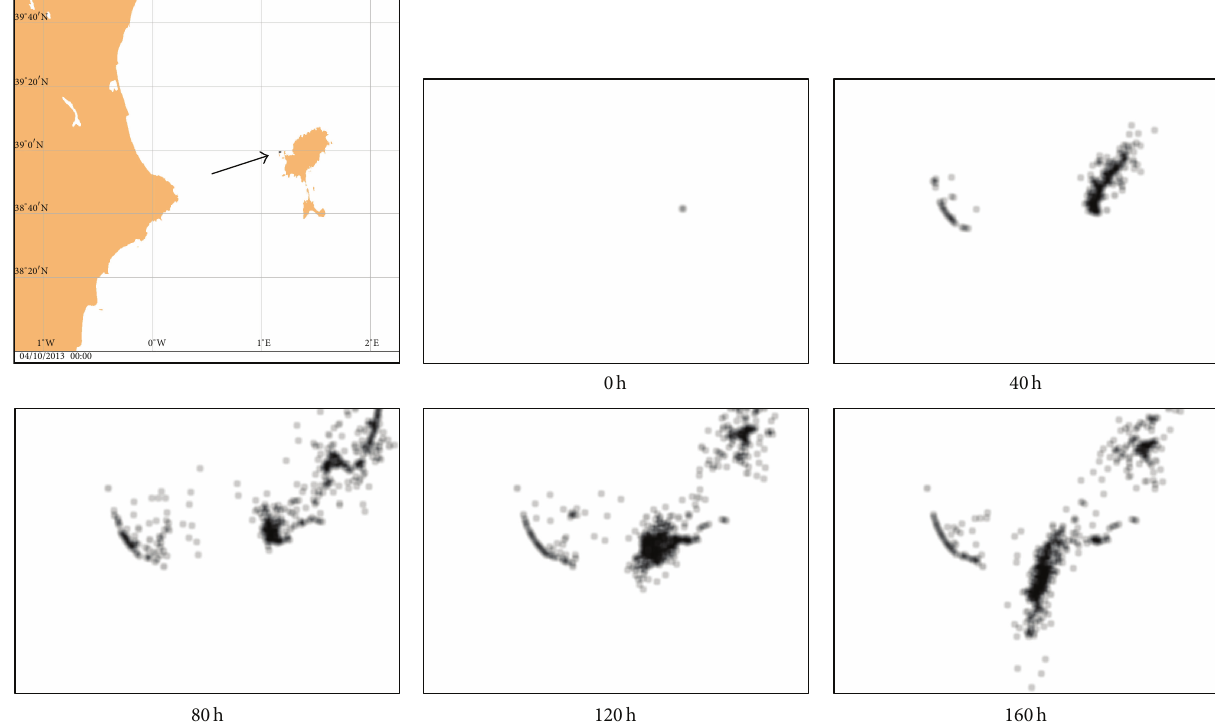
Figure 7: Origin and temporal evolution of the spill. Several snapshots that show the position of the spill at different instants, measured in hours from the beginning of the spill, are